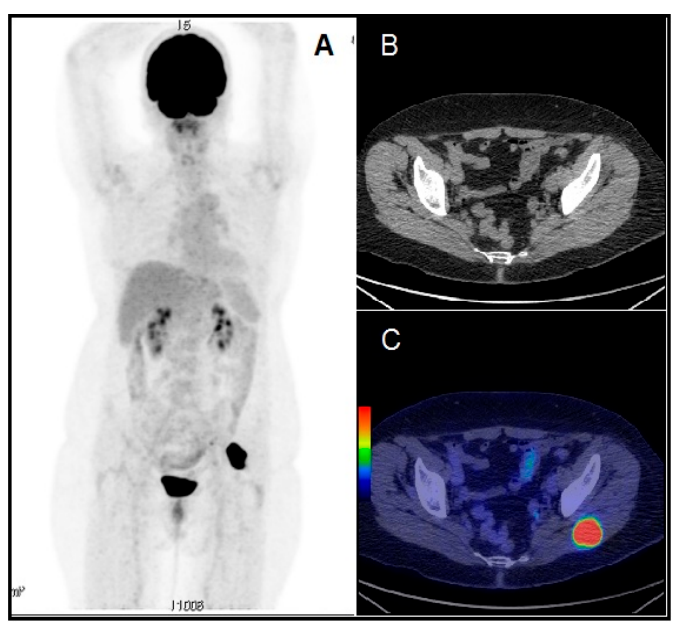
Figure 5. Whole body 18F-FDG PET/CT imaging revealed a right gluteal muscle tumor of 39 × 35 × 41 mm, with intense FDG uptake (SUV lbm max = 16.77) ( A ) 3D-MIP image. ( B ) CT axial image of the gluteal region. ( C ) PET/CT fusion image showing the intense uptake in the left gluteal muscle.